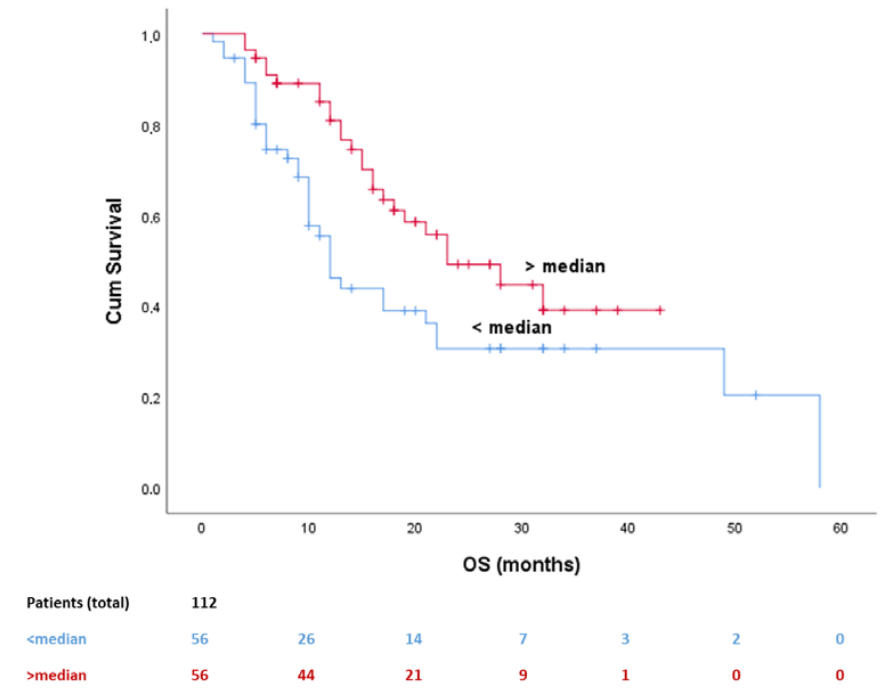
Figure 2. Kaplan–Meier curve for post immunotherapy OS dividing patients in two different predictive groups. OS, overall survival. Table 3. Univariate and multivariate analysis for OS.